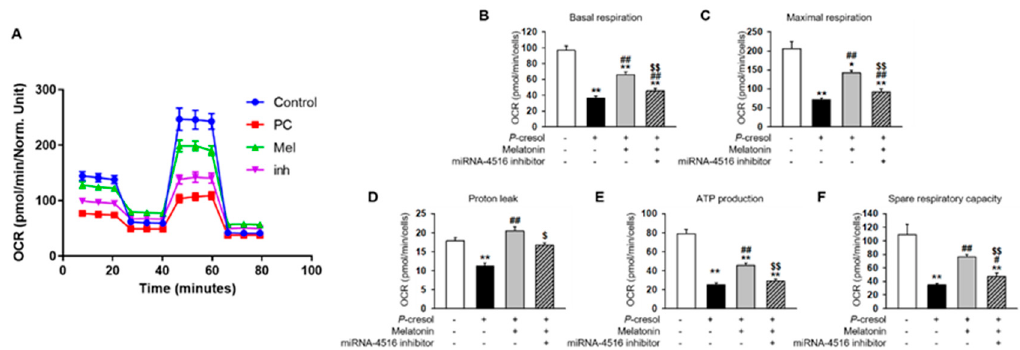
Figure 5. Melatonin restores mitochondrial function via increased expression of miR-4516. ( A ) Oxygen consumption rate (OCR) of each group was measured over time (min). The